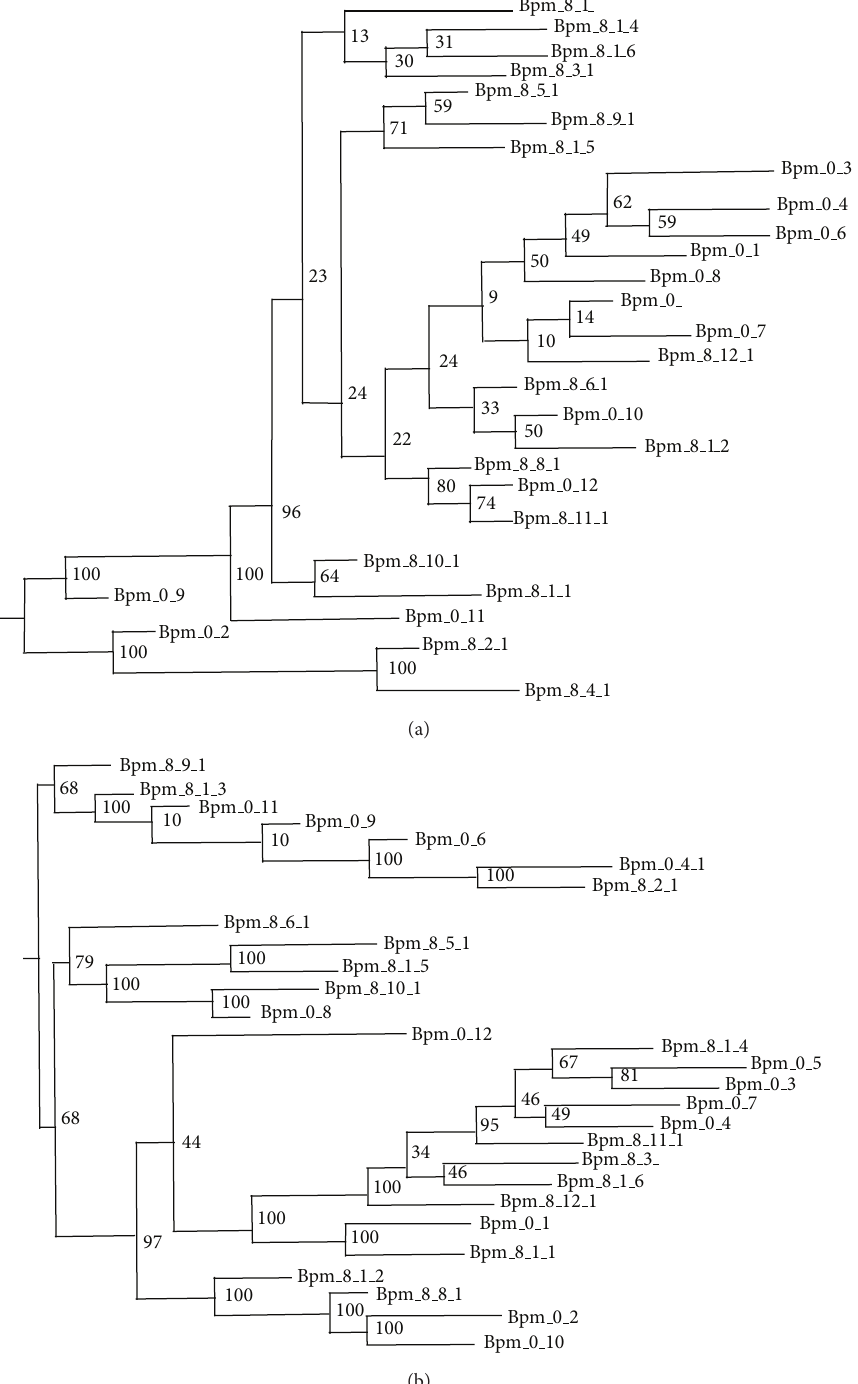
Figure 4: Five clones of the same lineage after passage 8 were sequenced and compared for SNPs. Posterior probabilities were calculated by the program SOAPsnp. This includes SNPs detected against the progenitor culture that was sequenced right after the first passage. (a) Illustrates chromosome 1. (b) Illustrates chromosome